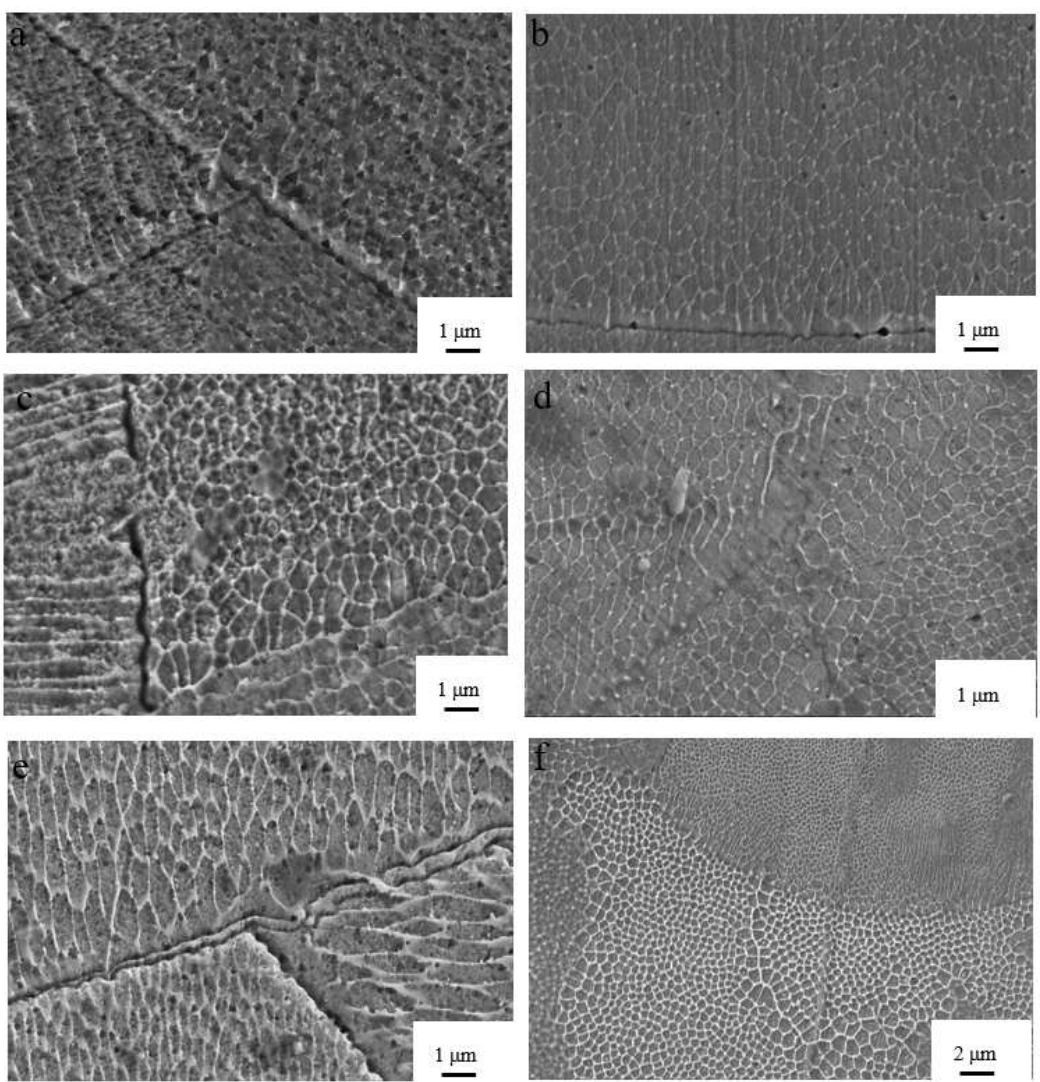
Figure 14. Scanning Electron Micrographs (SEM) of tissue structures at different energy densities: ( a ) E = 83.3 J/mm 3 , ( b ) E = 41.7 J/mm 3 , ( c ) E = 67.7 J/mm 3 , and ( d ) E = 100.0 J/mm 3 , ( e ) E = 111.1 J/mm 3 , ( f ) E = 57.1 J/mm 3 .